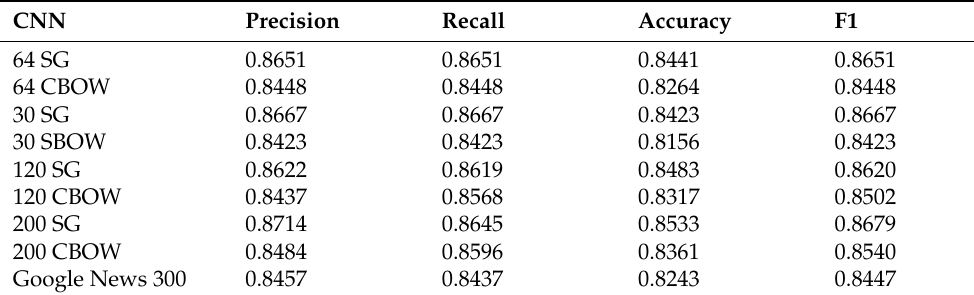
Table 2. Effectivity of CNN model with the topology presented in the Table